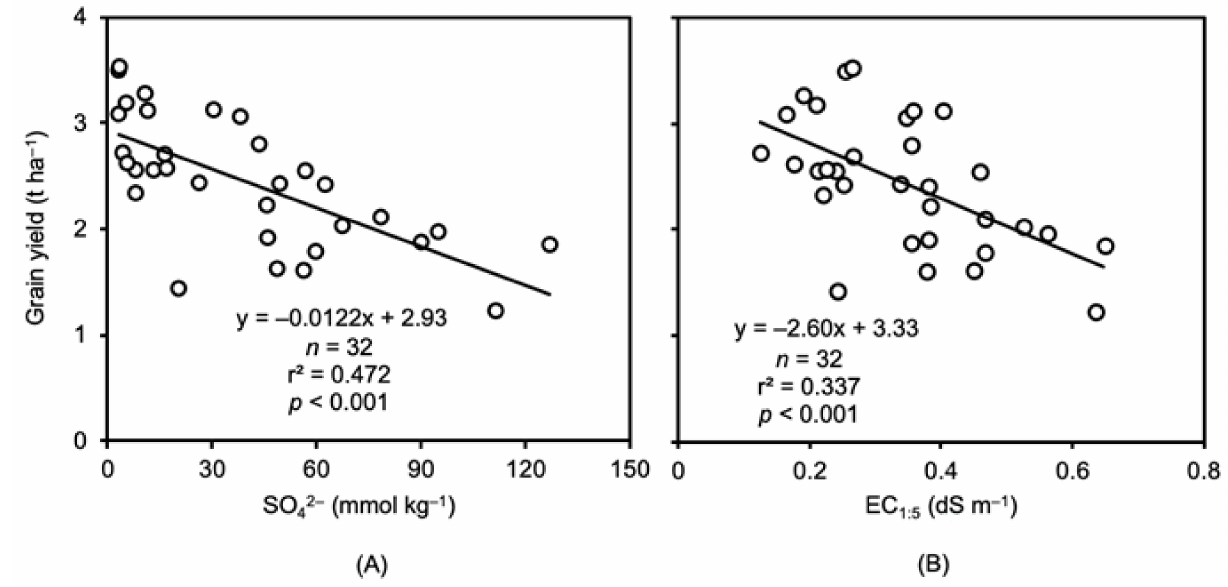
Figure 5. Best correlations between grain yield (2019) and soil chemistry (first time of sampling): ( A ) SO 42 − at 30–50 cm, and ( B ) EC 1:5 at 30–50 cm. The soil was a Vertic Calcic Calcisol located on Merredin Research Station ( − 31 ◦ 30 (cid:48) 25 (cid:48)(cid:48) S, 118 ◦ 13 (cid:48) 04 (cid:48)(cid:48)